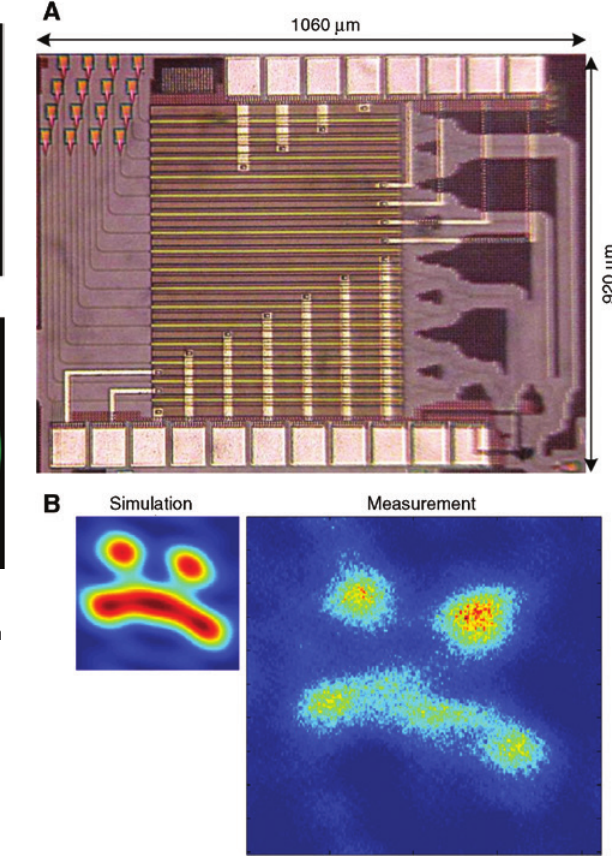
Figure 8: Projection chip based on silicon photonics. (A) Microscope picture of a 4 × 4 integrated OPA, realized on silicon, with high-speed phase control per channel. (B) Projected image of a “smiley” obtained by using a fast vector scan of the beam spot, showing simulated (left) and experimental (right) results. Reprinted by permission of The Optical Society [22].